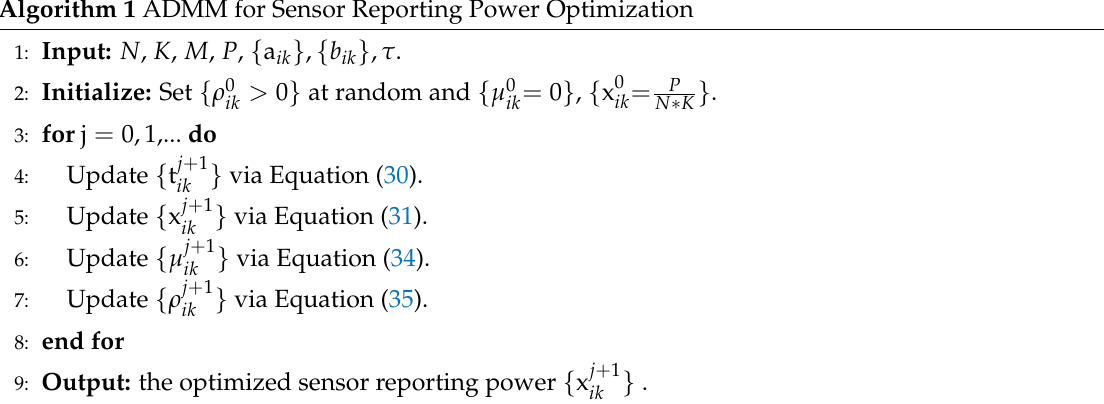
Algorithm 1 ADMM for Sensor Reporting Power